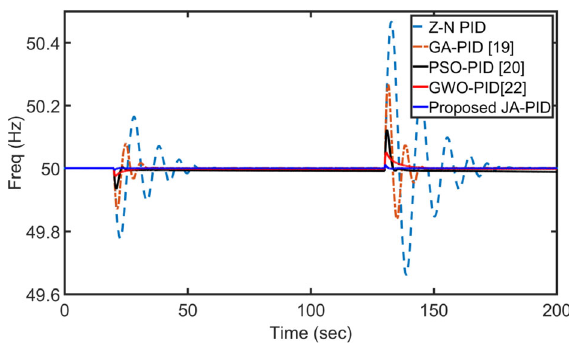
Fig. 8 Scenario 1 frequency deviation response